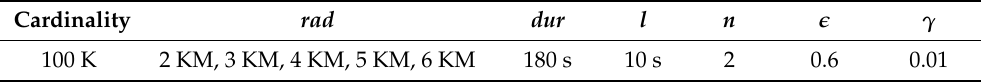
Table 5. Setting of synthetic data parameters and algorithm parameters in radius